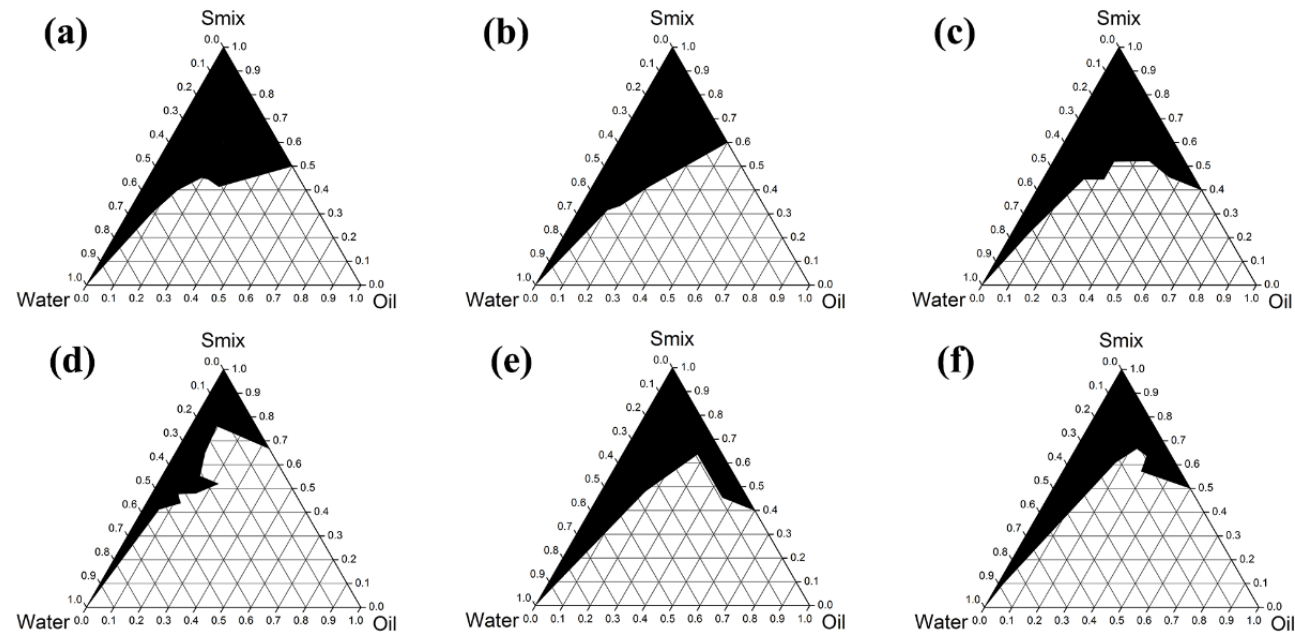
Figure 4. Chemical structures of ethanol ( a ), propan-2-ol ( b ), PG ( c ), glycerin ( d ), and PEG ( e ).